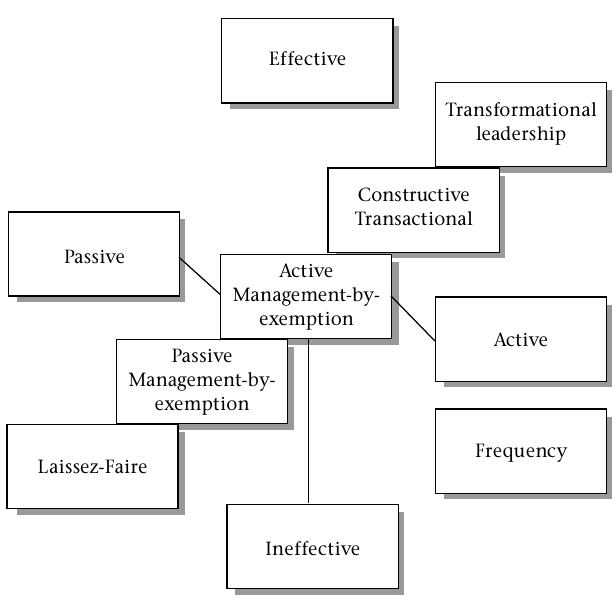
Figure 1: Leadership Model adapted from Bass and Avolio (1997, p.